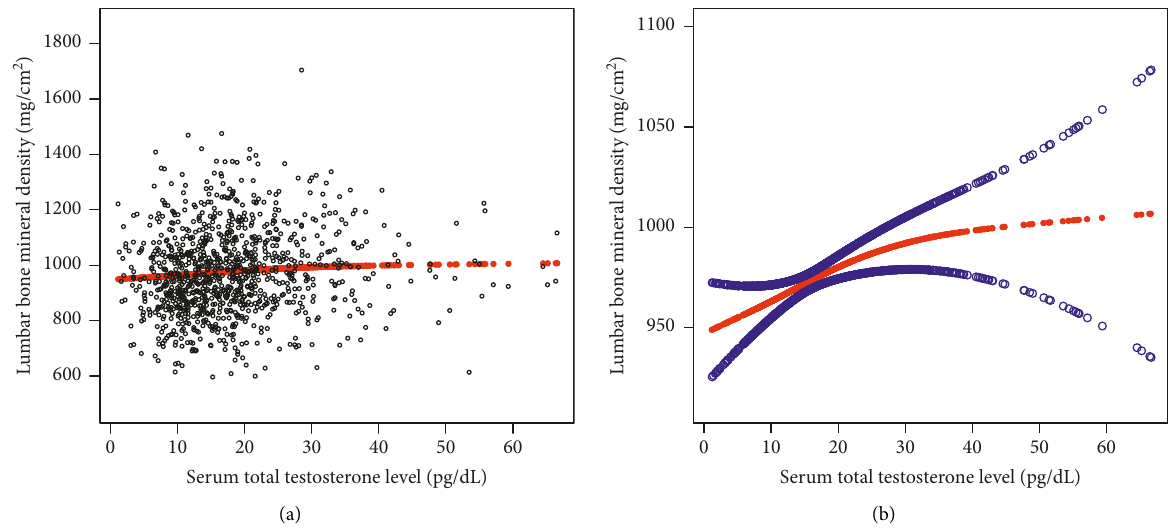
Figure 2: The association between serum total testosterone level and bone mineral density. (a) Each black point represents a sample. (b) Solid red line represents the smooth curve fit between variables. Blue bands represent the 95% of confidence interval from the fit (adjusted for age, race, body mass index, education level, income to poverty ratio, moderate activities, age since menopause, blood urea nitrogen, serum uric acid, total protein, serum phosphorus, and serum calcium). Table 4: Threshold effect analysis of serum total testosterone level (ng/dL) on lumbar bone mineral density (mg/cm 2 ) using two- piecewise linear regression model.